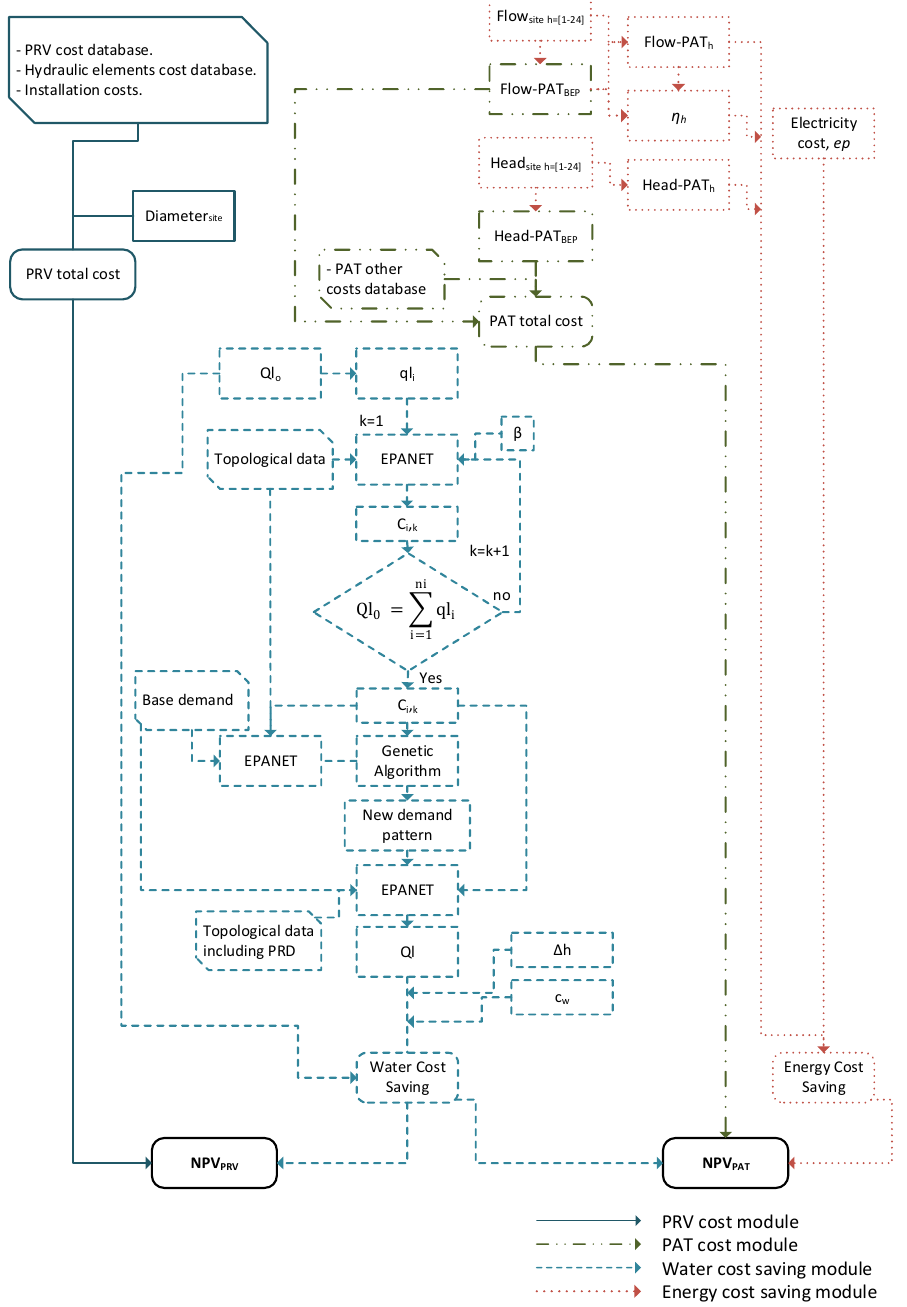
Figure 1. Flow chart of the model to determine the most cost-effective device.